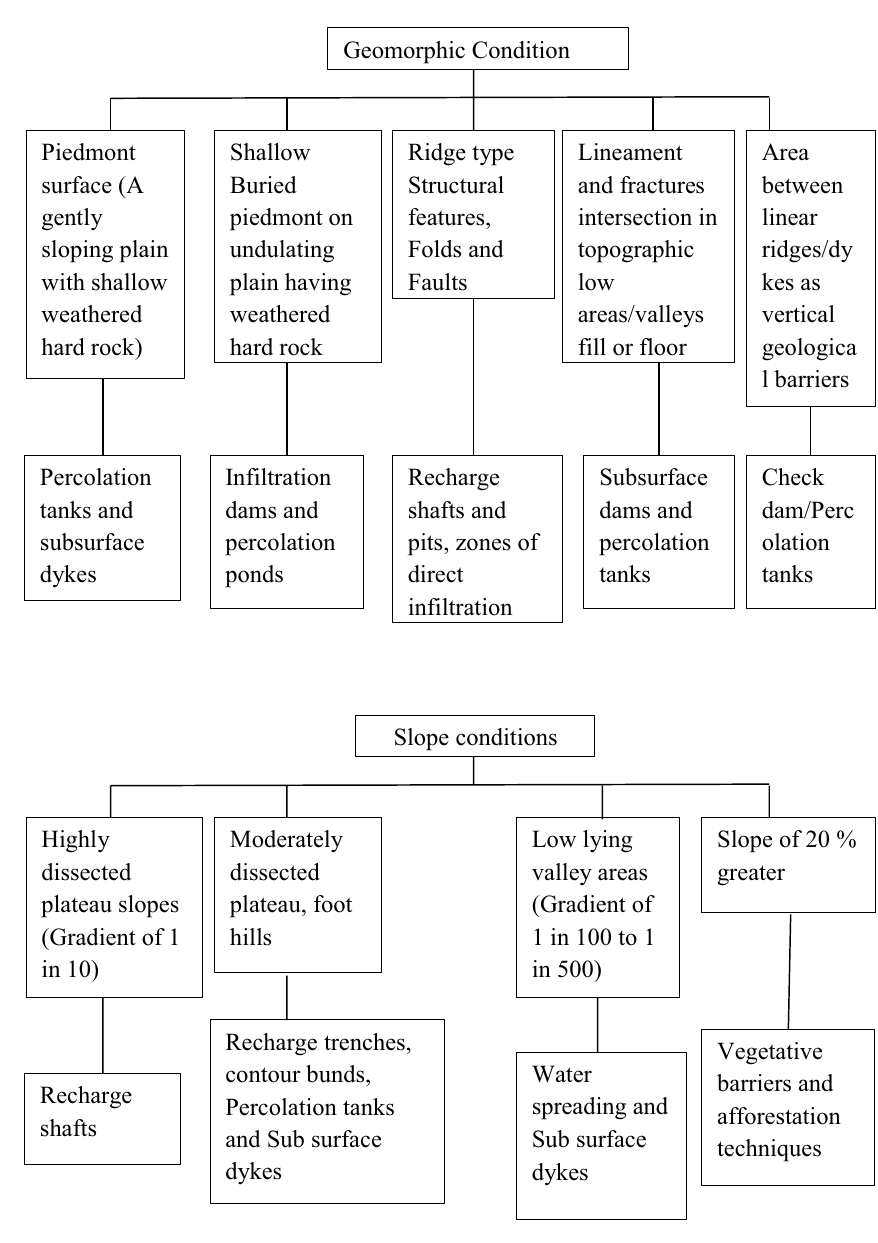
Fig. 16 Decision support model (DSM) based on Geomorpho- logical Condition